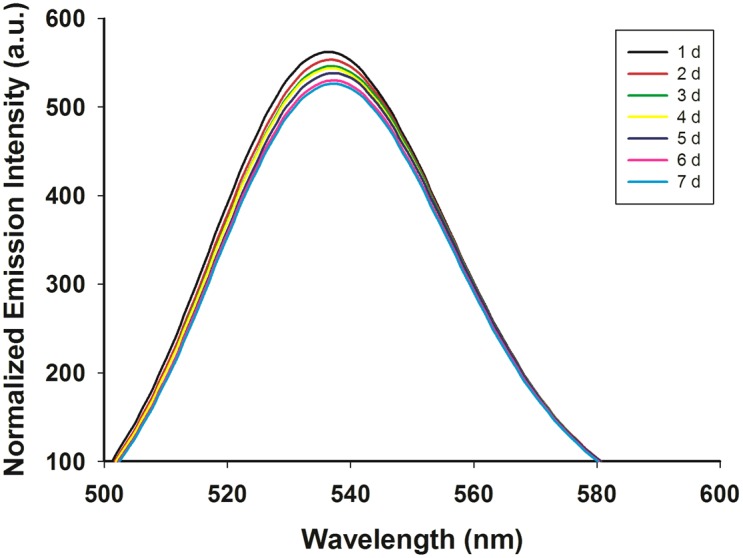
Emission spectra of QDs in H2O over 7 days.